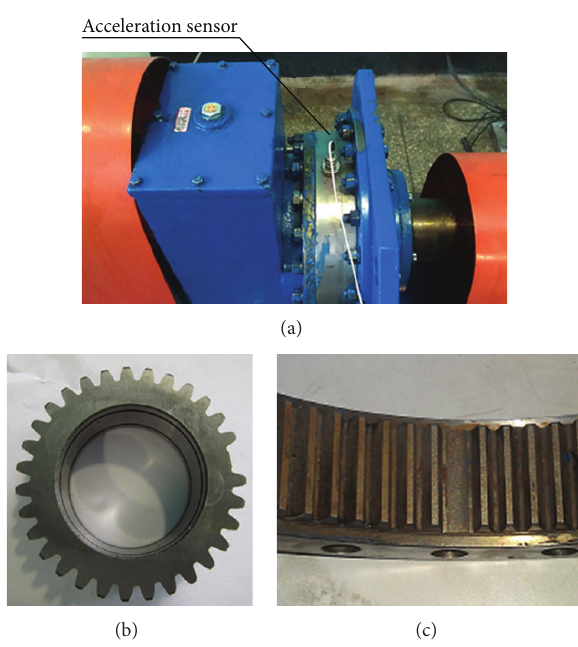
Figure 8: The acceleration sensor and breakage tooth: (a) acceler- ation sensor position, (b) planet gear with tooth breakage, and (c) ring gear with tooth breakage.